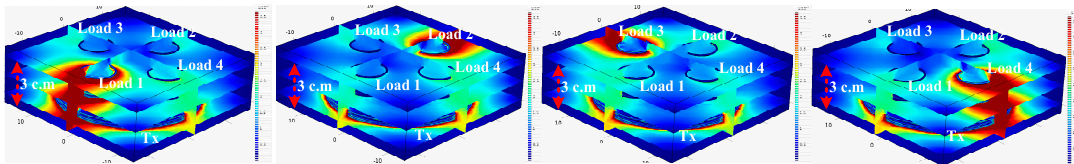
Figure 13. Magnetic field Intensity of Selective Power Transfer with lateral separation of 3 cm.